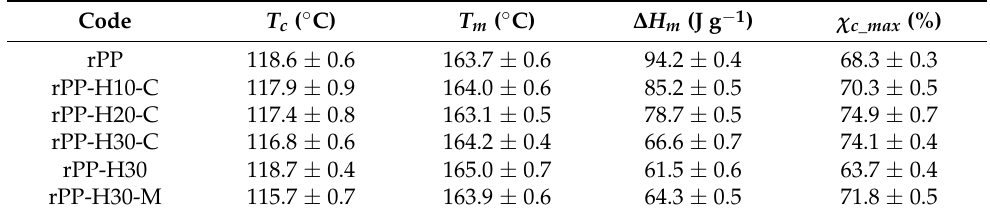
Figure 3. DSC thermograms of rPP/hemp fiber composites’ ( a ) cooling cycle and ( b ) second heating cycle. Table 3. Main thermal transitions obtained from DSC thermograms of the rPP/hemp fiber composites with different